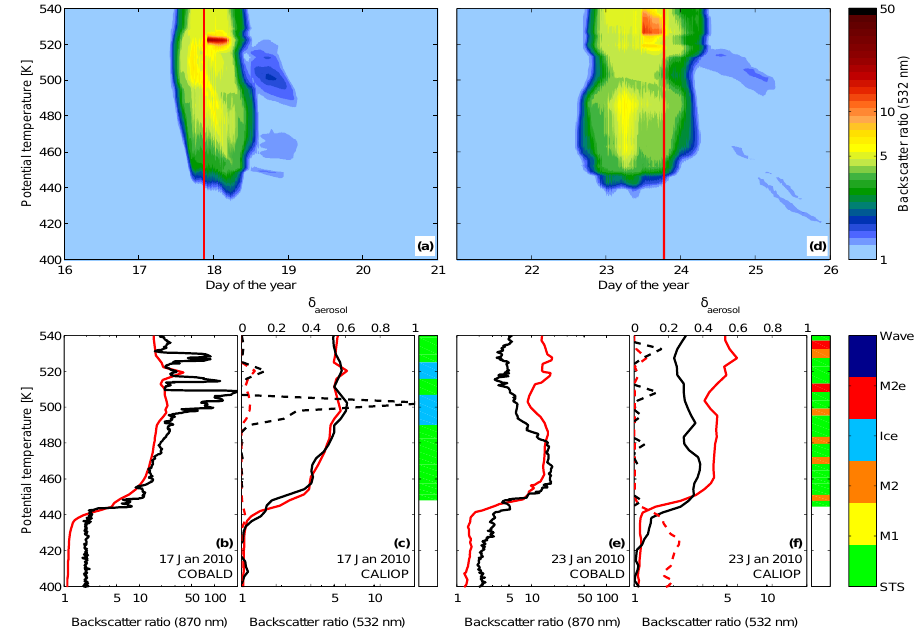
Fig. 3. Results from the microphysical column model ZOMM driven by ERA-Interim based CLaMS trajectories with superimposed small- scale temperature fluctuations. Upper panels (a, d) : time series of backscatter ratios (BSR) at 532nm (color coded); vertical red lines: S1 and S2. Lower panels: comparison between simulations (red) and measurements (black), namely COBALD BSR at 870nm (b, e) and CALIOP BSR (solid) and depolarization (dashed) at 532nm (c, f) . Simulations (red lines) in (c) and (f) have been interpolated corresponding to the vertical resolution of the instrument. Color bars: PSC classification scheme according to Pitts et al. (2011) for CALIOP observations. CALIOP data are from orbits 2010-01-18T00-19-57Z (c) and 2010-01-24T01-22-07Z (f) closest to